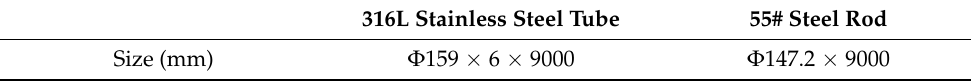
Figure 1. Appearance and morphology of the composite billet. Table 2. Specifications and size of the billet.